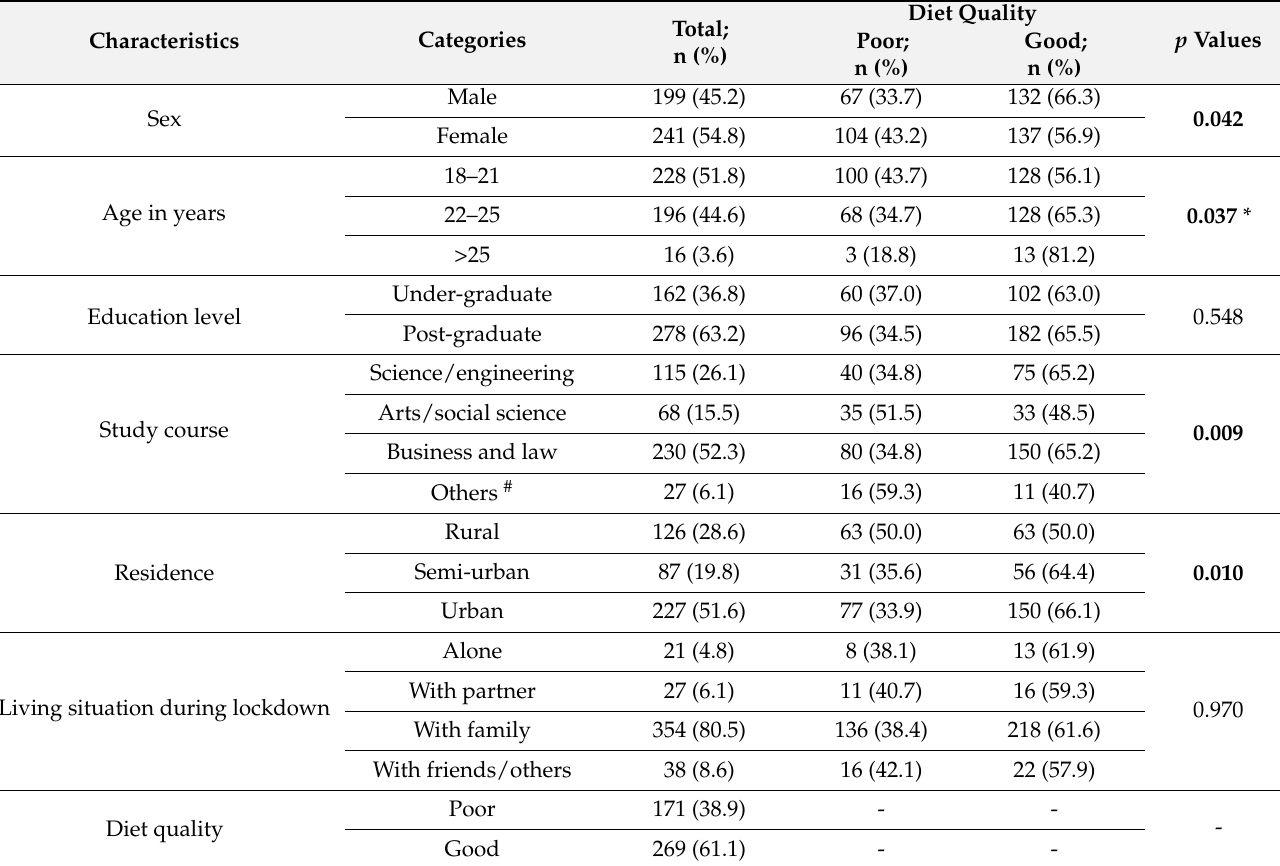
Table 1. Distribution of diet quality across different socio-demographic characteristics of study participants during the COVID-19 pandemic in India (n =